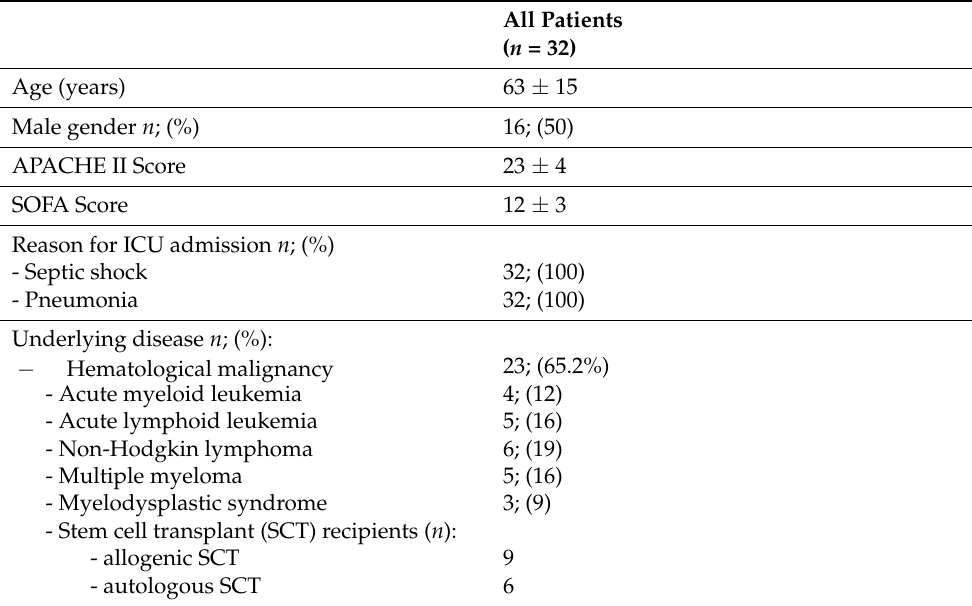
Table 1. Clinical characteristics of the cohort including risk/host factors for invasive